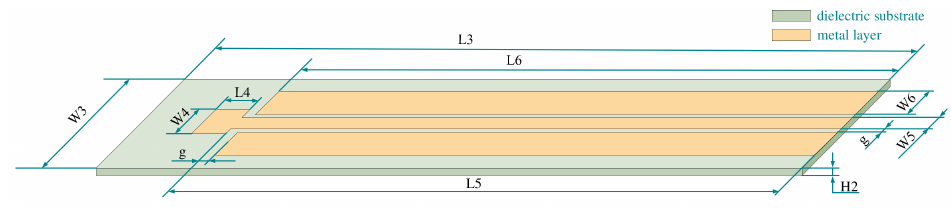
Figure 4. Interrogation antenna plane structure.